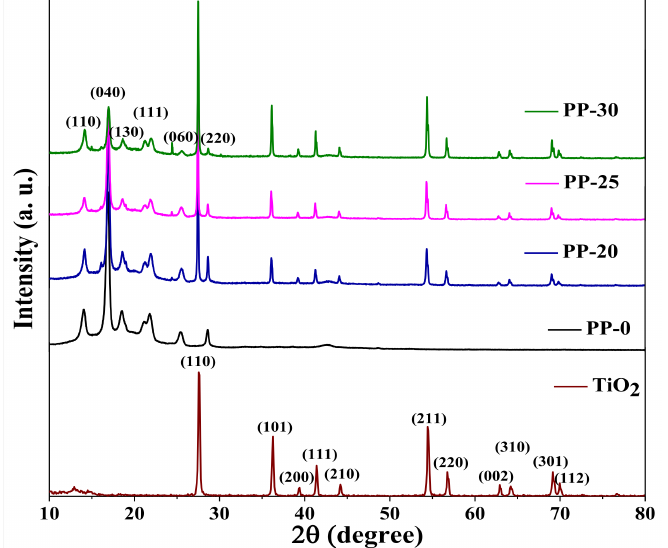
Figure 2. X-ray diffraction patterns of the composites PP–TiO 2 /lignin (PP-20, PP-25, and PP-30), polypropylene (PP-0), and TiO 2 .